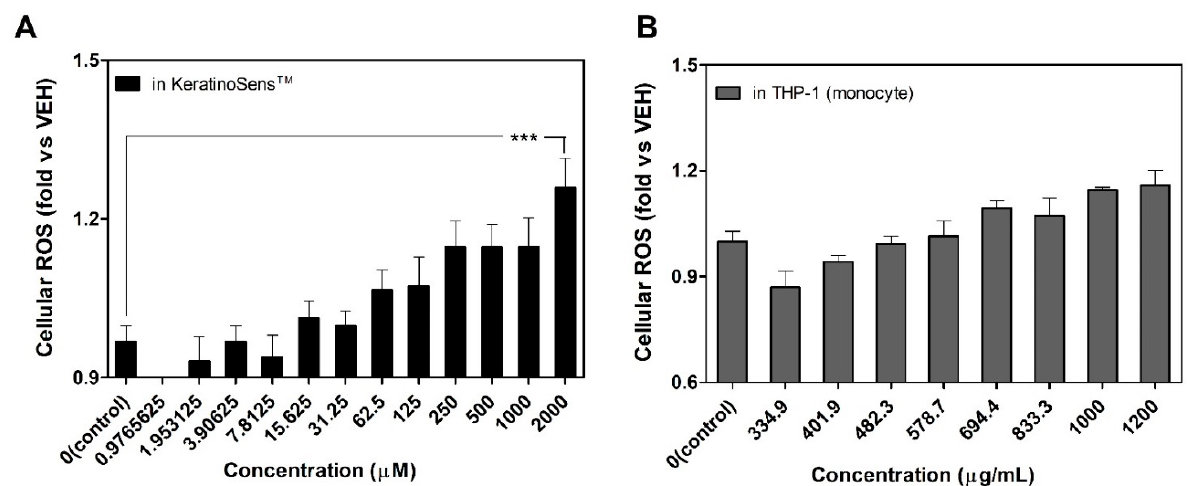
Figure 5. Evaluation of intra-cellular ROS generation treated with silica NPs. The levels of cellular ROS generated in ( A ) KeratinoSens TM cells and ( B ) THP-1 cells. Data are expressed as mean ± SEM ( n = 4). *** p < 0.0001 compared to vehicle control group. ROS = reactive oxygen species, VEH = vehicle control.